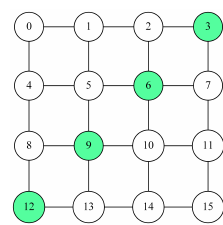
Figure 1. Diagonal nodes in the grid